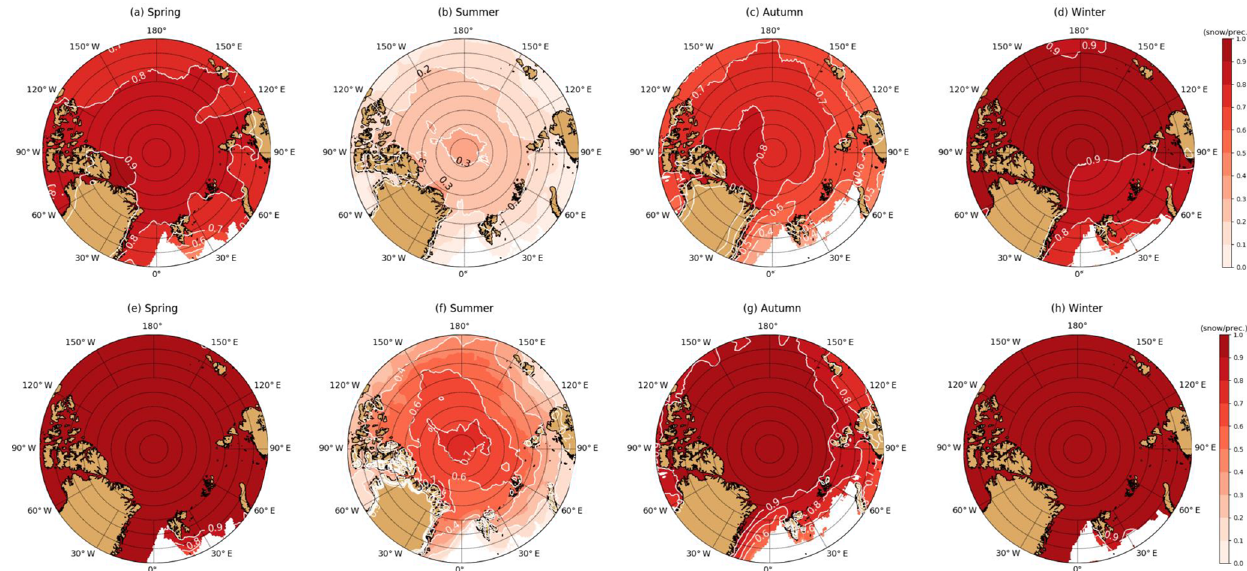
Figure 8. The ratio of snowfall to total precipitation (SF / TP) in ERA-I (a–d) and ERA5 (e–h) in spring (a, e) , summer (b, f) , autumn (c, g) and winter (d, h)